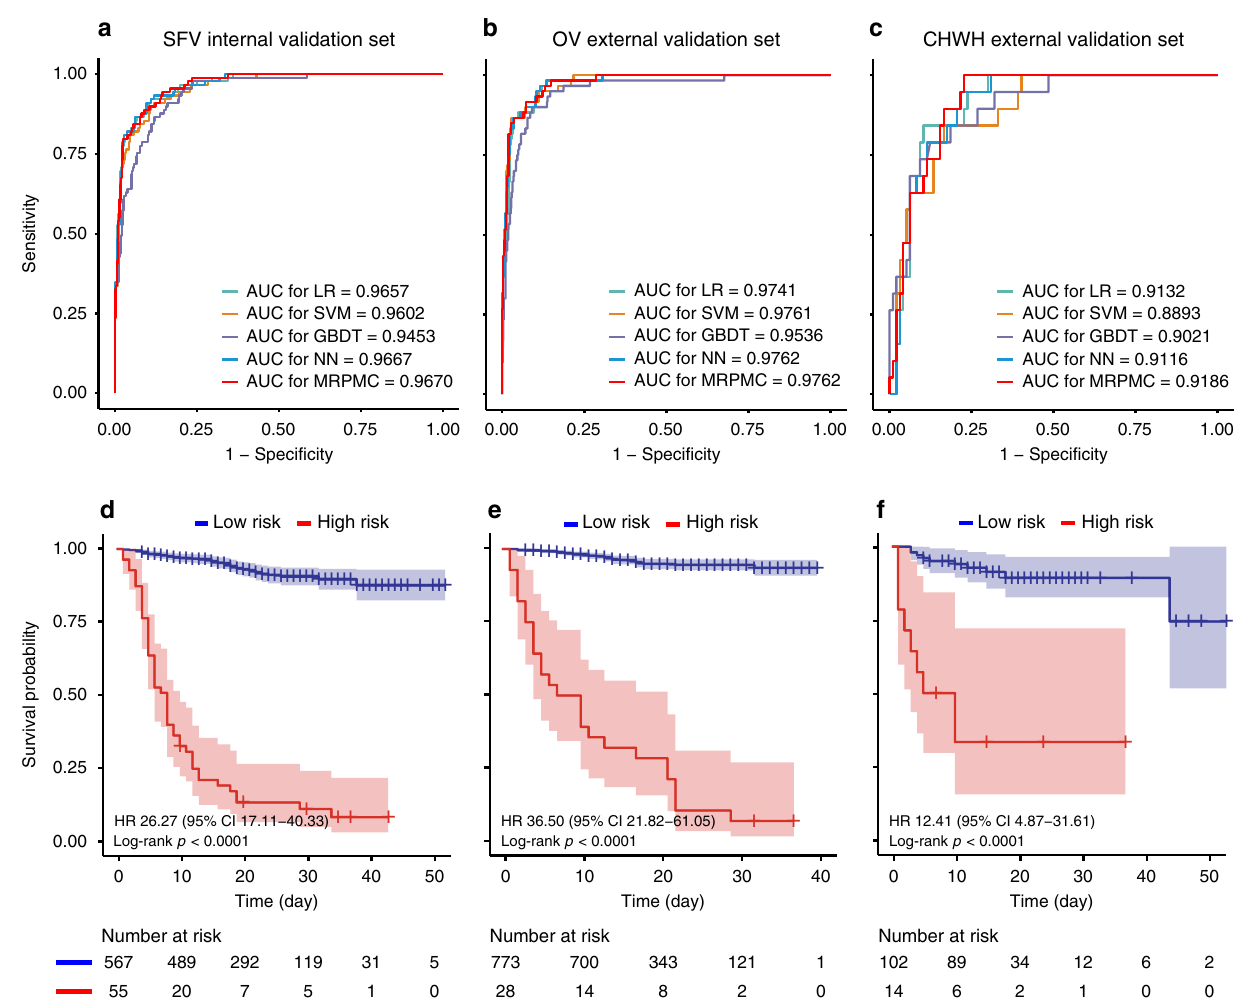
Fig. 3 Predictive performance of models across cohorts. AUC to assess the performance of mortality risk prediction of models (LR, SVM, GBDT, NN, and MRPMC) in a SFV cohort, b OV cohort, and c CHWH cohort, respectively. Source data are provided as a Source Data fi le. Kaplan – Meier curves indicating overall survival of patients with high and low mortality risk in d SFV cohort, e OV cohort, and f CHWH cohort, respectively. The tick marks refer to censored patients. The dark red or blue line indicates the survival probability, and the light red or blue areas represent the 95% con fi dence interval of survival probability ( p < 0.0001). AUC area under the receiver operating characteristics curve, SFV internal validation cohort of Sino-French New